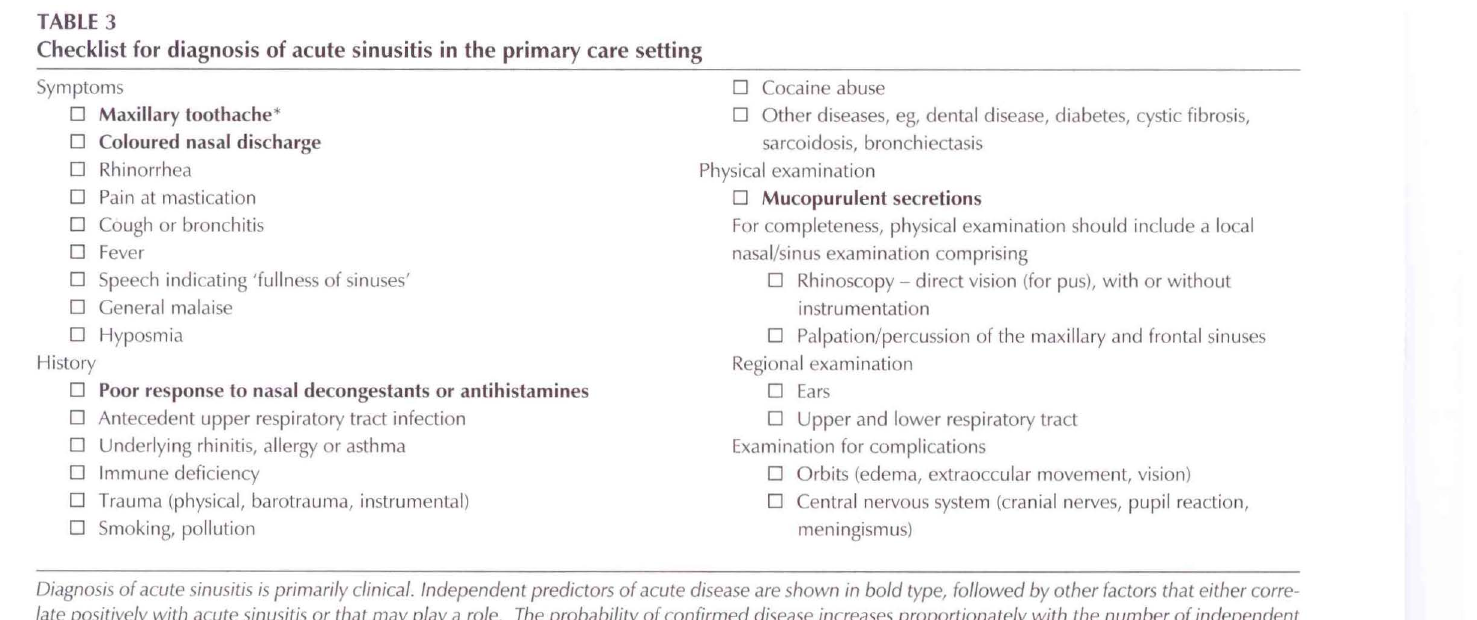
Checklist for diagnosis of chronic sinusitis in the primary care